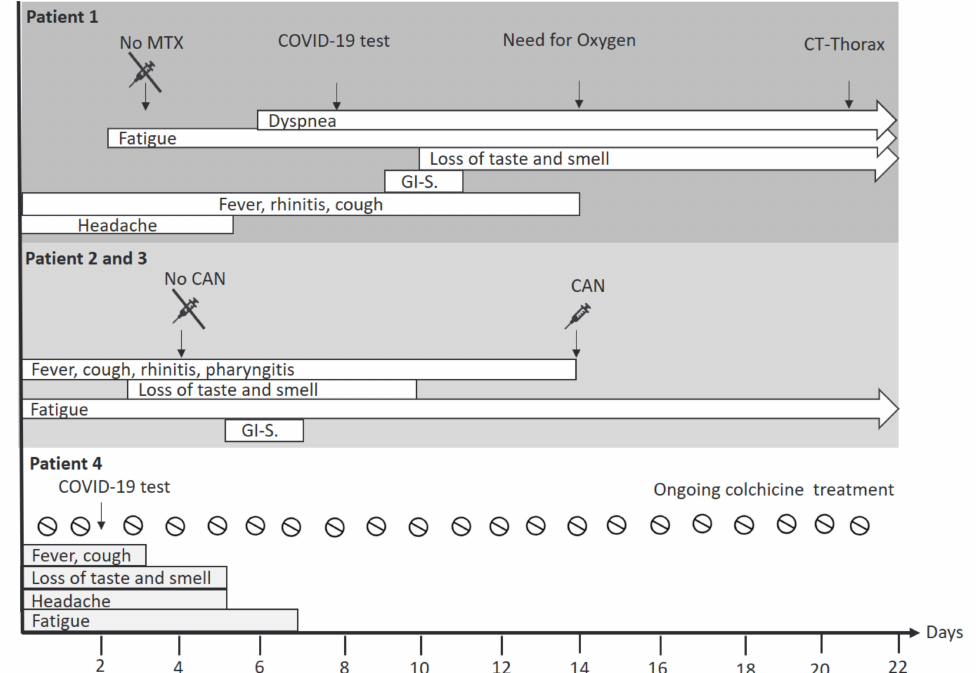
Figure 2. Overview of symptoms of the acute COVID-19 disease course in AID patients. Acute COVID-19 disease course was less severe in the three adolescent AID patients with canakinumab maintenance treatment as compared to the adult patient treated with methotrexate. Particularly patient 4, who was treated with daily colchicine and who had received canakinumab 150 mg s.c. 4 days before COVID-19 was confirmed, had a short and mild disease course. Abbreviations: CAN: Canakinumab; CT: Computed tomography; COVID-19: Coronavirus disease 2019; GI-S.: Gastrointestinal symptoms such as nausea, diarrhea, emesis, abdominal pain; MTX: Methotrexate. Legend: ongoing disease symptoms on day 22 after (cid:9) COVID-19